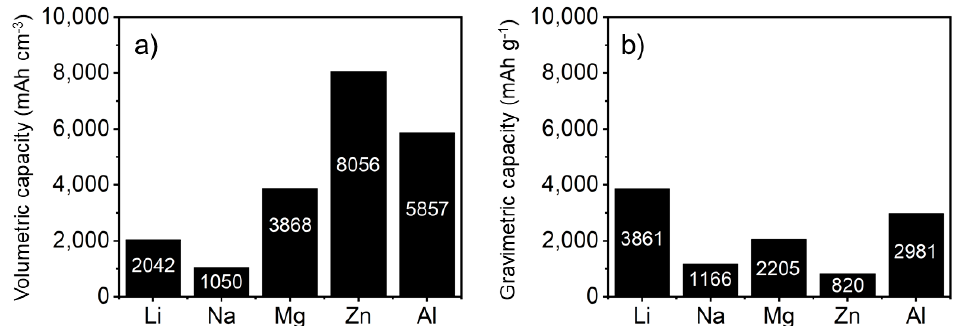
Figure 3. Comparison of volumetric capacity ( a ) and gravimetric capacity ( b ) of different metals [14].